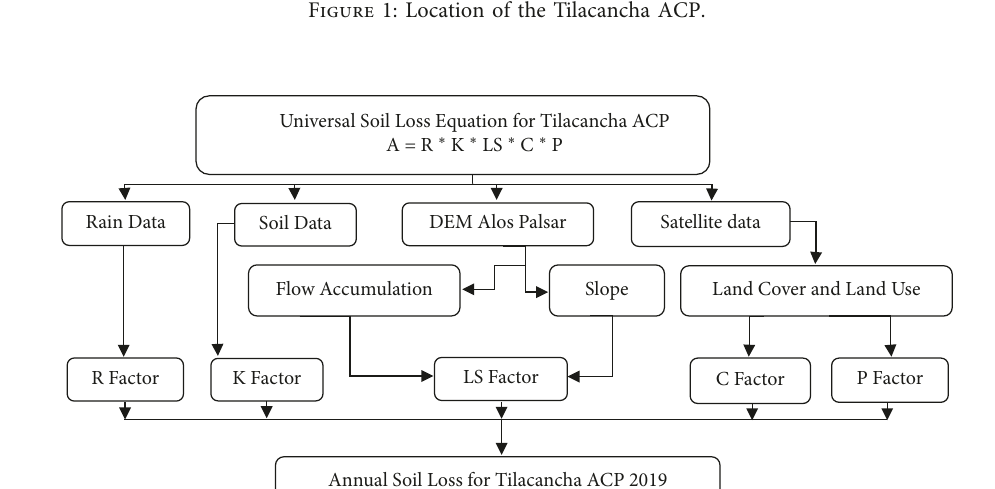
Figure 1: Location of the Tilacancha